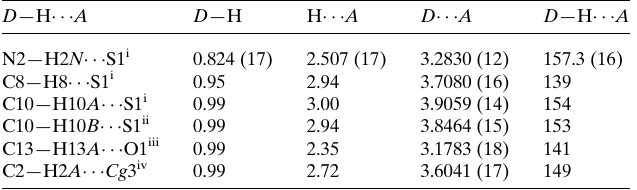
ring. These contacts combine to stack molecules of the complex in a regular fashion along the b -axis direction, Fig. 5. Further details of the intermolecular interactions in 1 were obtained using Hirshfeld surface analysis (Spackman & Jayatilaka, 2009) with Hirshfeld surfaces and two-dimensional fingerprint plots generated with CrystalExplorer17 (Turner et al. , 2017). Hirshfeld surfaces for opposite faces of 1 are shown in Fig. 6( a ) and ( b ). Bold red circles on the Hirshfeld surfaces